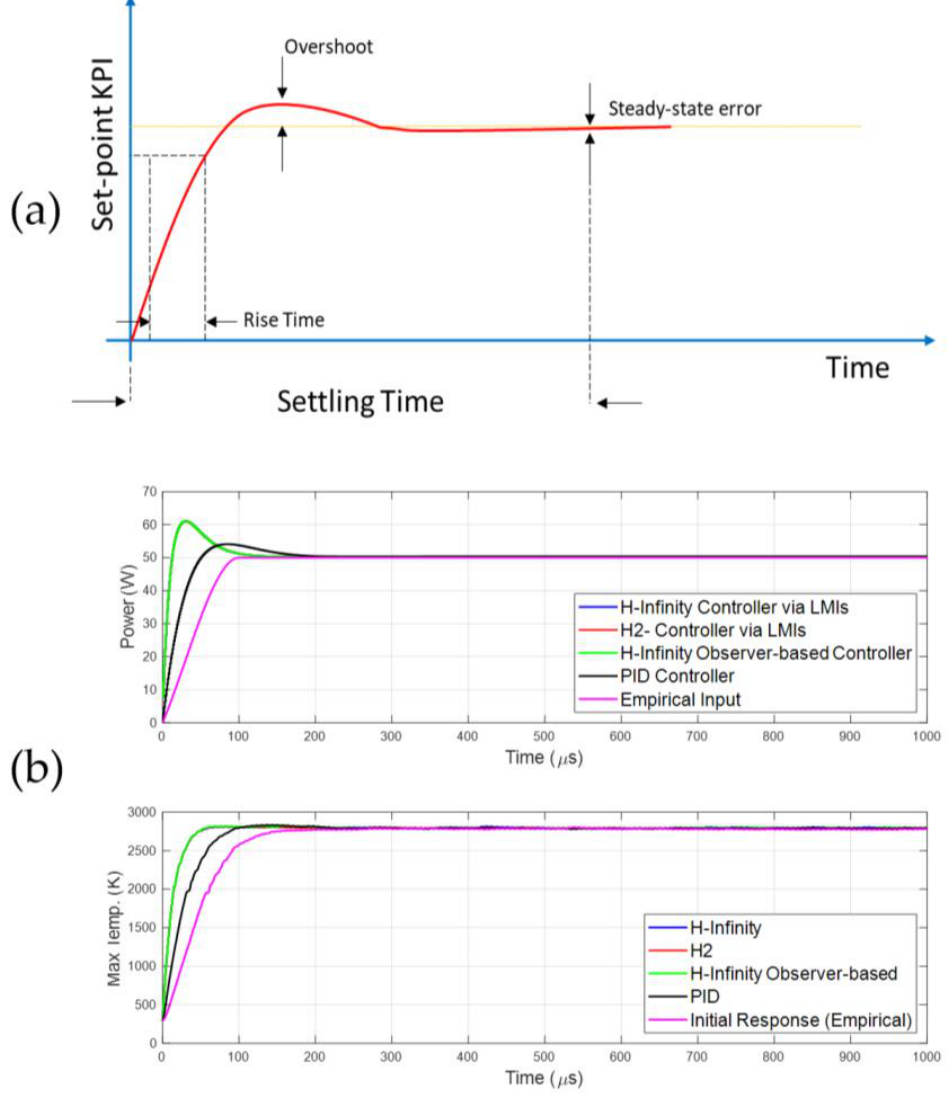
Figure 11. Step response metrics ( a ), robust optimization solution based on LMIs in comparison with a fine-tuned PID controller ( b ). Table 2. Comparison of developed controllers with relevant literature.